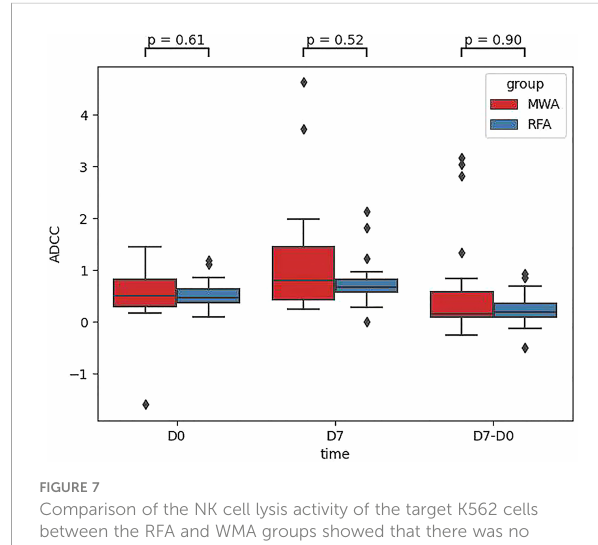
FIGURE 6 The comparison of CD107a between the RFA and WMA groups (D7- D0) suggested that there was a signi fi cant difference between the two groups in inducing CD107a production in NK cells at D7-D0 (P<0.05),microwave-induced changes were stronger.